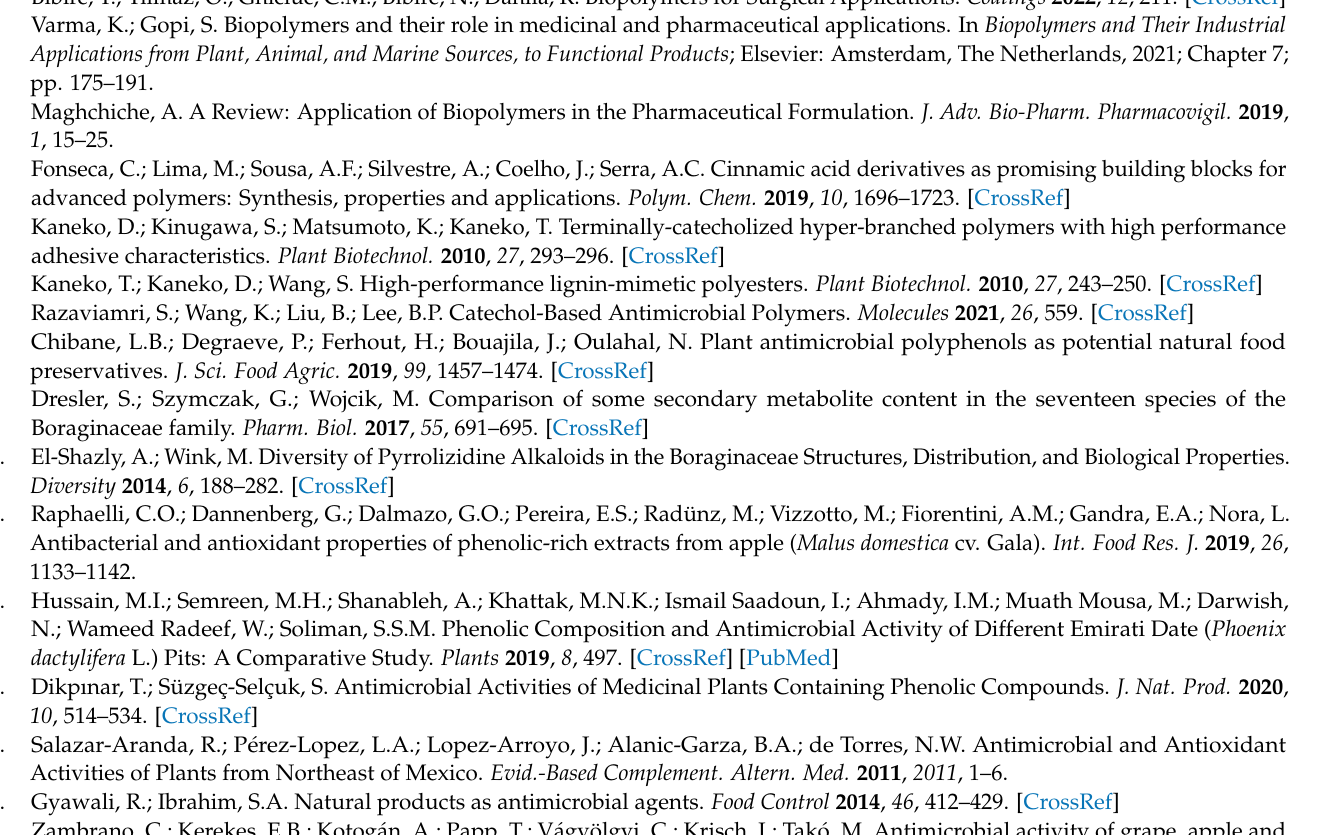
Figure S1. UV spectra (H 2 O, λ max , nm) of PDHPGA-SA, PDHPGA-SC, PDHPGA-SG, PDHPGA-AI, PDHPGA-CO and PDHPGA-BO; Figure S2. The IR spectra of PDHPGA-SA, PDHPGA-SC, PDHPGA-SG, PDHPGA-AI, PDHPGA-CO and PDHPGA-BO; Figure S3. The 13 C NMR spectrum of PDHPGA-SA, PDHPGA-SC and PDHPGA-CO; Figure S4. The 1 H NMR spectrum of PDHPGA-SA, PDHPGA-SC and PDHPGA-CO; Figure S5. The HSQC spectrum of PDHPGA-SA, PDHPGA-SC and PDHPGA-CO; Figure S6. The 13 C NMR spectrum methylated in carboxylic groups of PDHPGA-SG, PDHPGA-AI and PDHPGA-BO; Figure S7. The 1 H NMR spectrum of methylated in carboxylic groups of PDHPGA-SG, PDHPGA-AI and PDHPGA-BO; Figure S8. The 2D DOSY spectrum of PDHPGA (R=H) and methylated in carboxylic groups of PDHPGA (R=CH 3 )